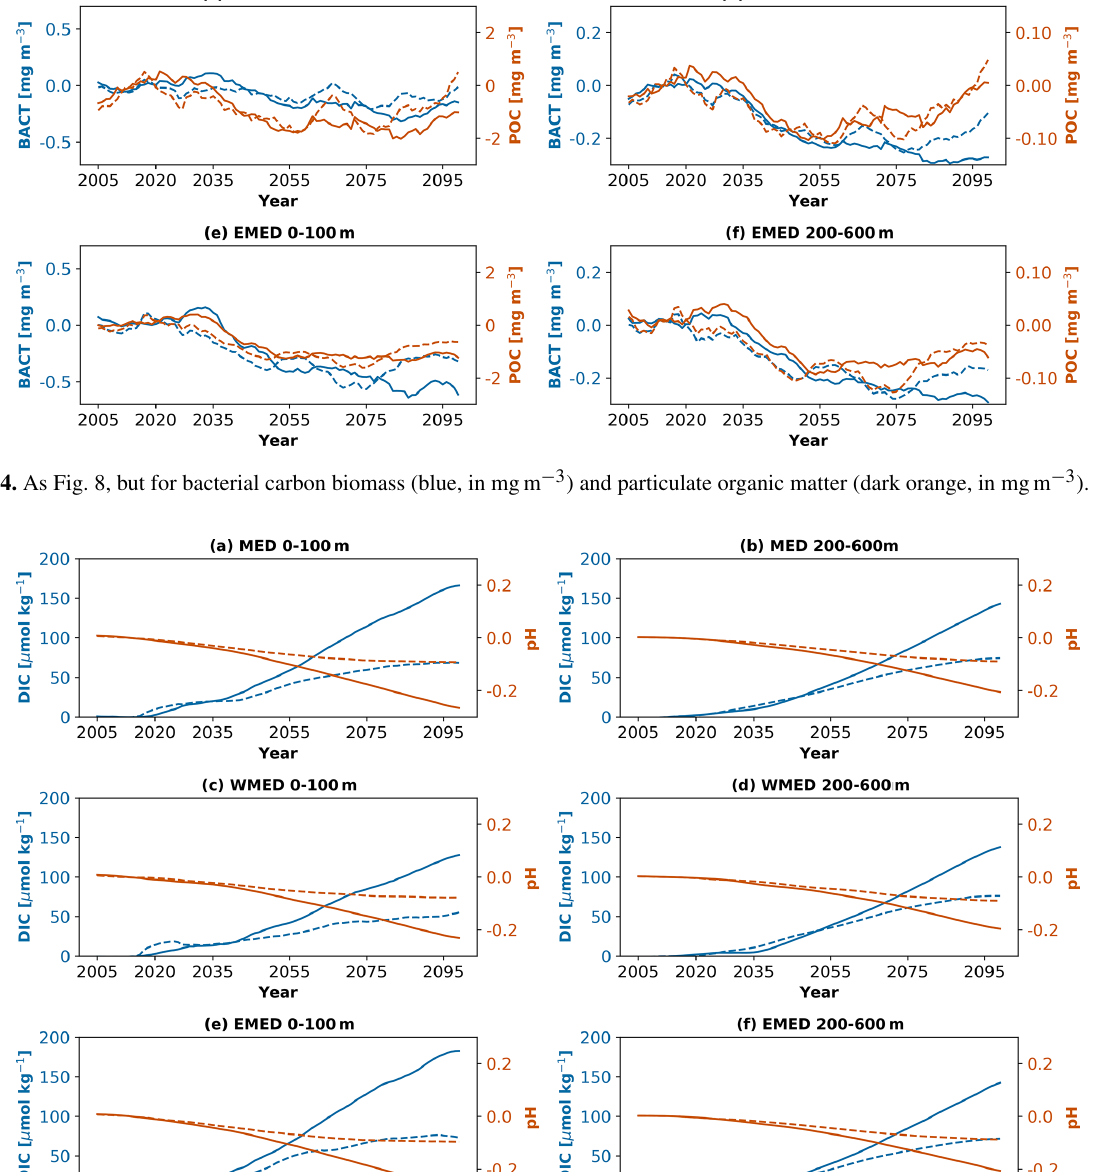
Biogeosciences, 19, 4035–4065, 2022